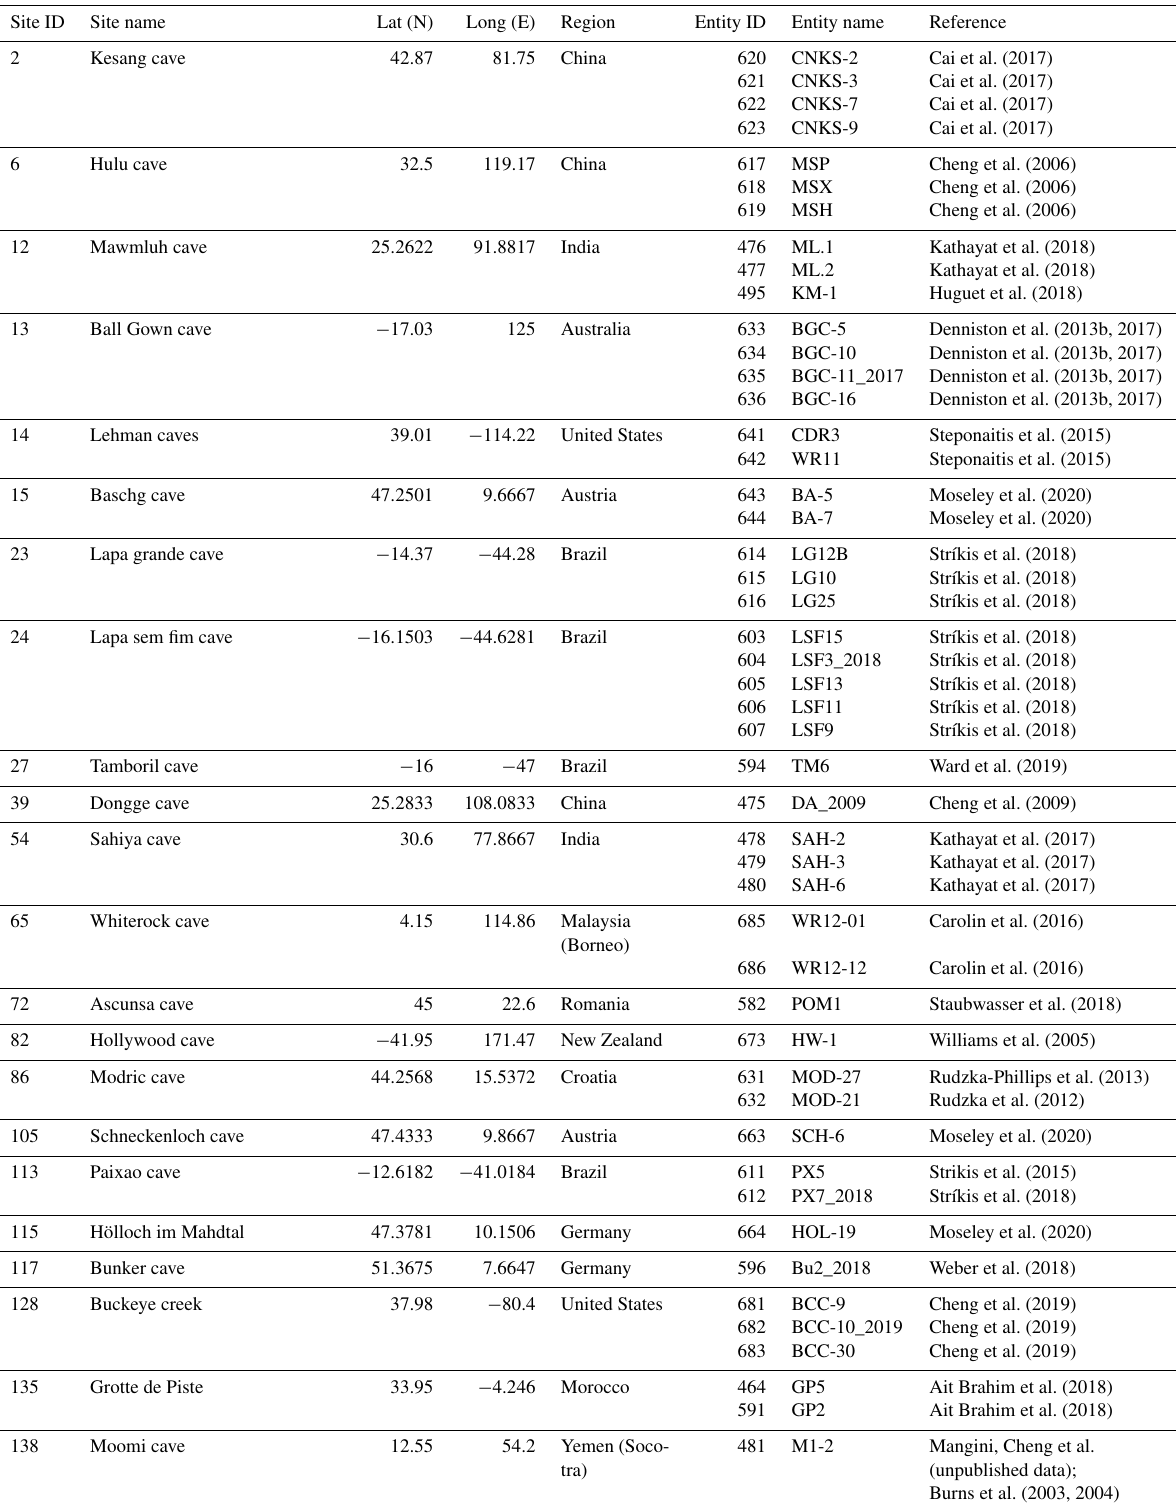
Table 5. Information on new speleothem records (entities) added to the SISAL_v2 database from SISALv1b (Comas-Bru et al., 2019). There may be multiple entities from a single cave, here identified as the site. Latitude (Lat) and Longitude (Long) are given in decimal degrees north and east,